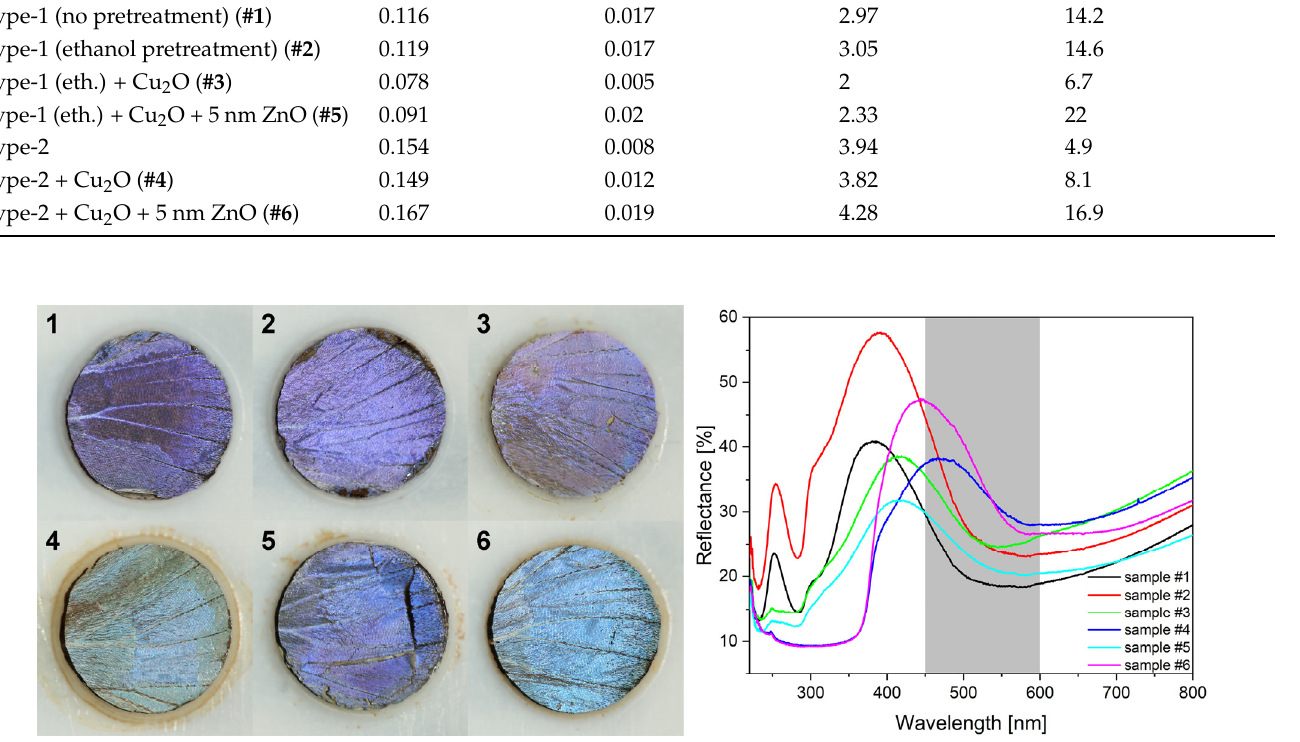
Figure 9. Photographs ( left ) of the wing samples used in the photocatalytic experiments in as- prepared state and the corresponding reflectance spectra ( right ): ( 1 ) type-1 sample without ethanol pretreatment; ( 2 ) type-1 sample with ethanol pretreatment; ( 3 ) type-1 sample with 120 μ L of Cu 2 O sol drop dried; ( 4 ) type-2 sample with 120 μ L of Cu 2 O sol drop dried; ( 5 ) type-1 sample with 120 μ L of Cu 2 O sol drop dried, followed by the deposition of 5 nm of ZnO; ( 6 ) type-2 sample with 120 μ L of Cu 2 O sol drop dried, followed by the deposition of 5 nm of ZnO. The grey-shaded area marks the rhodamine B absorption band. Table 1. Reaction rates and relative reaction rates (with bare glass as unity) of the samples tested. Except for the comparison samples with simple structure (glass and glass + 15 nm ZnO, for these values are taken from [38]), averages for three independent photodecomposition experiments are shown. Note that a large volume of RhB solution (20 cm 3 ) was used with a circular photocatalytic surface of 8 mm in diameter.